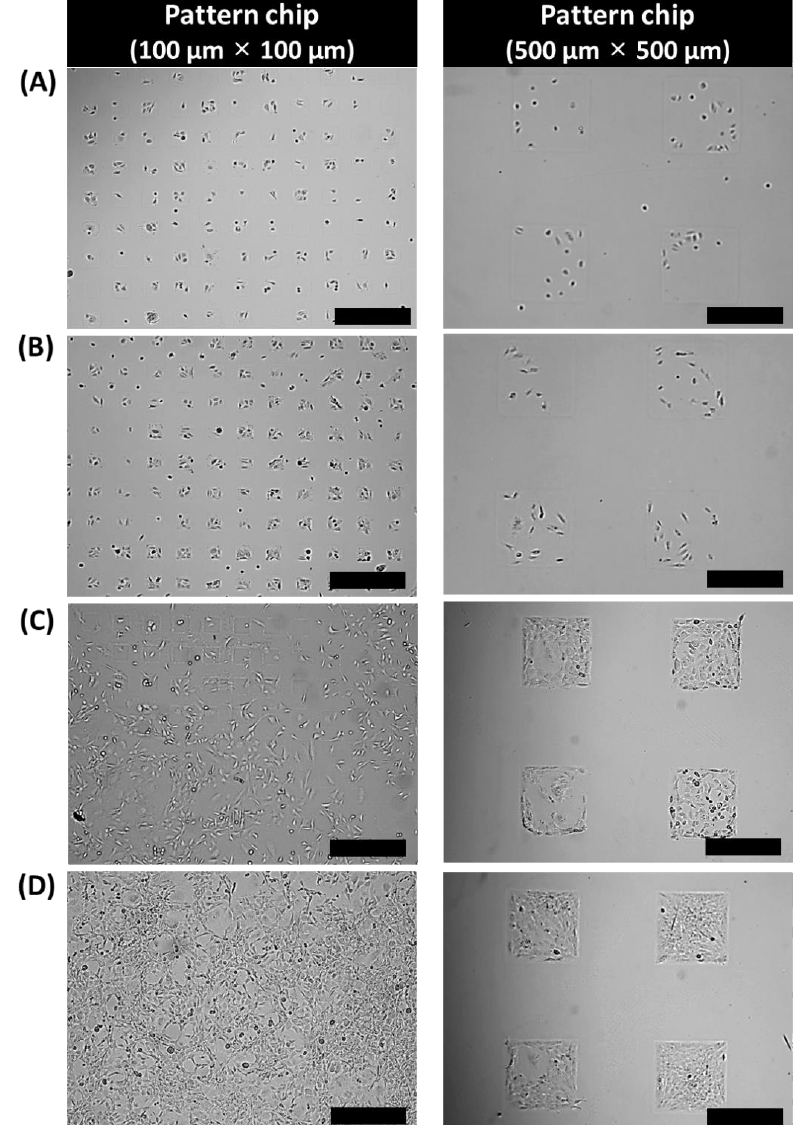
Figure 2. Optical images of 3T3-L1 cells on the adipocyte micro-cell pattern chip after ( A ) 2 h, ( B ) 12 h, ( C ) 24 h, and ( D ) 72 h. Scale bar indicates (left panel) 100 μ m and (right panel) 300 μ m. ( C ) 24 h, and ( D ) 72 h. Scale bar indicates (left panel) 100 µ m and (right panel) 300 µ